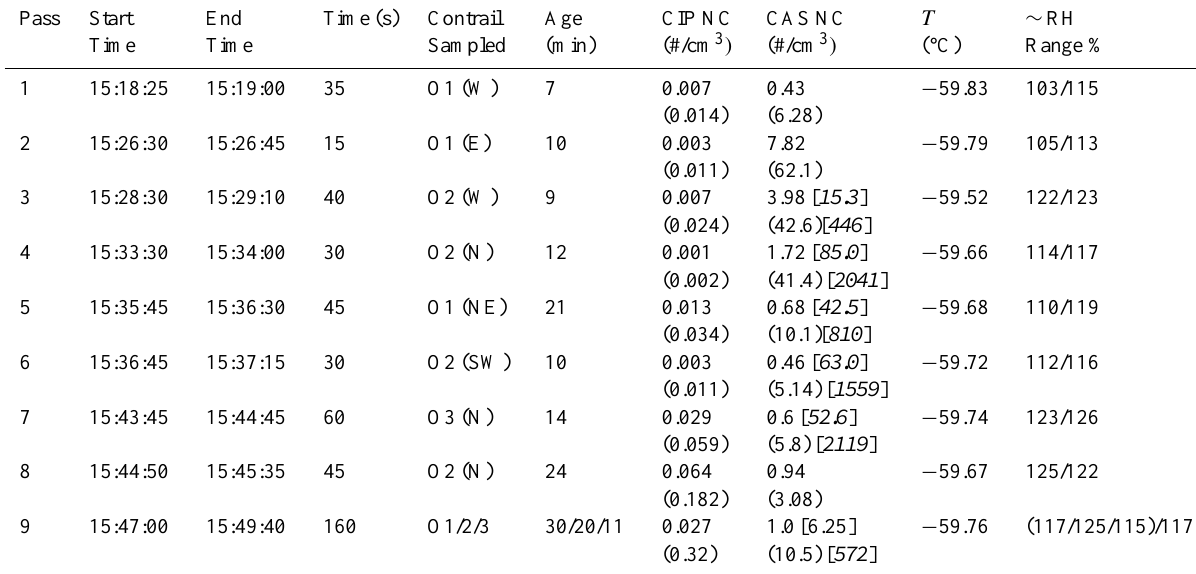
Table 1. Information regarding contrail penetrations made during initial orbits of Flight B587. Mean (max) CIP-GS and CAS number con- centration (#/cm 3 ) are reported. CAS values in square brackets are mean and max concentrations when concentrations > 50cm 3 are included. ∼ RH is calculated from (ambient) saturated vapour pressure calculations using the de-iced temperature from the Rosemount/Goodrich sen- sor and dew point temperature as measured by the General Eastern chilled mirror hygrometer, at which the specific part of the contrail was